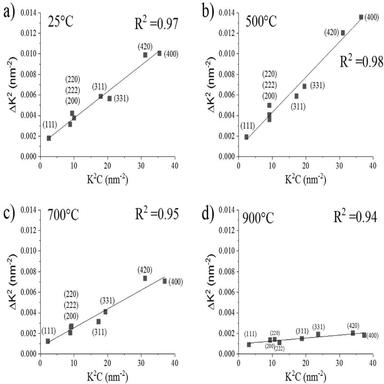
Modified Williamson-Hall plots obtained with X-ray diffraction data at strain ¼ 0.2 of Alloy 709 from room temperature to 900 C.